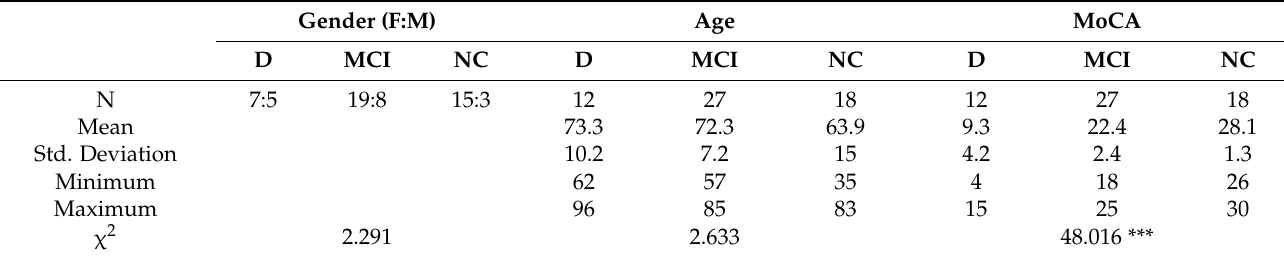
Table 1. Participant demographic data, gender, and MoCA results.